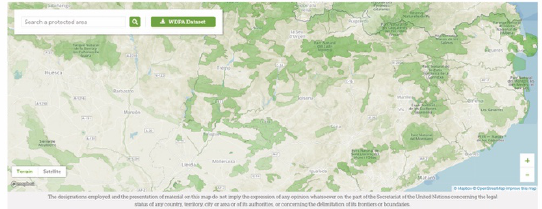
Figure4 WDPA map of natural protected areas in a polygonal